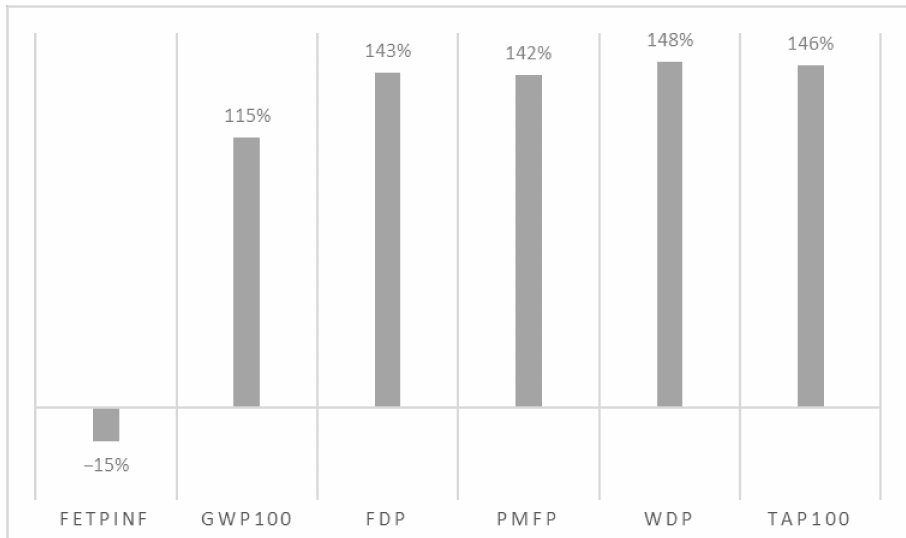
Figure 14. Percentage variation in each impact category for the recycled plastic scenario compared to the virgin plastic scenario. FETPinf: freshwater ecotoxicity; GWP100: climate change; FDP: fossil depletion; PMFP: particulate matter formation; WDP: water depletion; TAP100: terrestrial